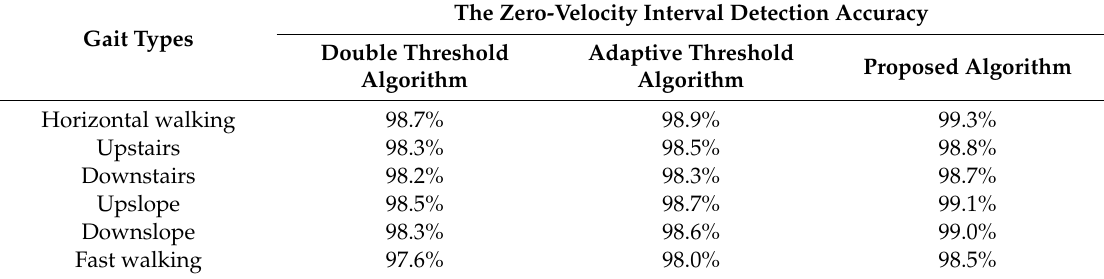
Table 1. The comparison results of zero-velocity interval detection accuracy.